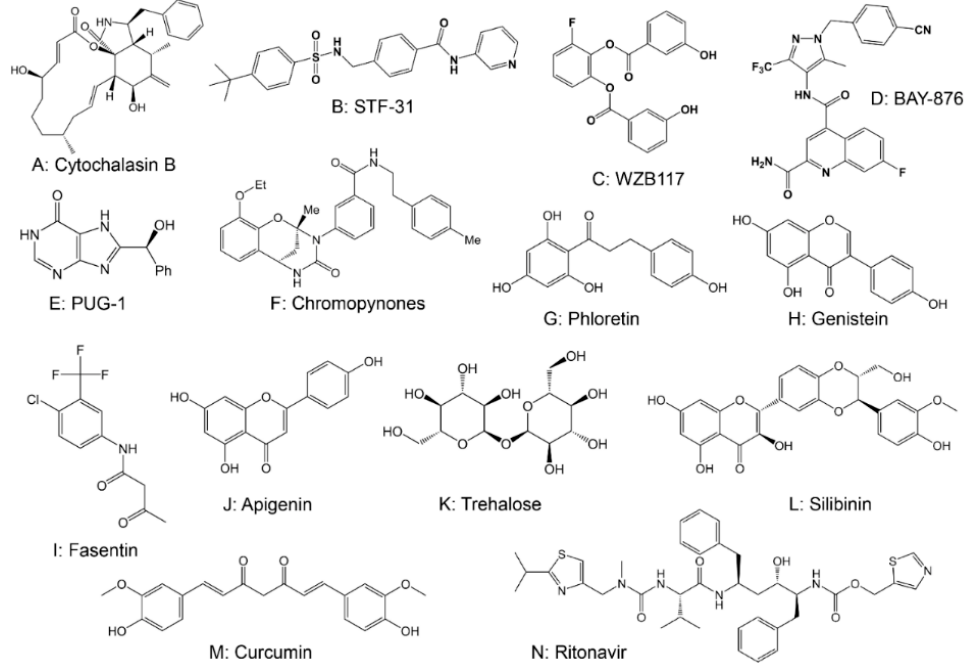
Figure 3. The chemical structures of drugs targeting glucose transferase.